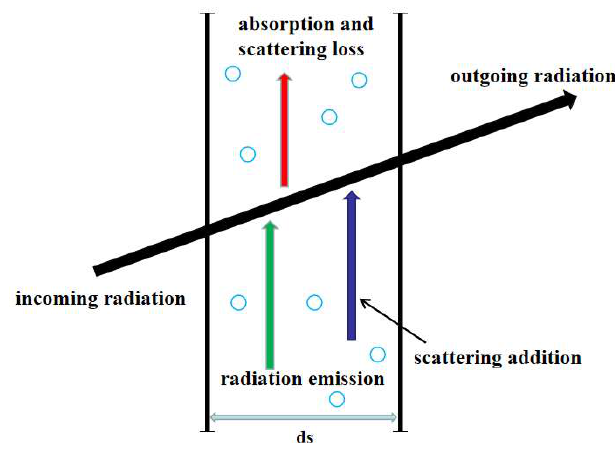
Figure 8. The schematic diagram of radiative heat transfer.